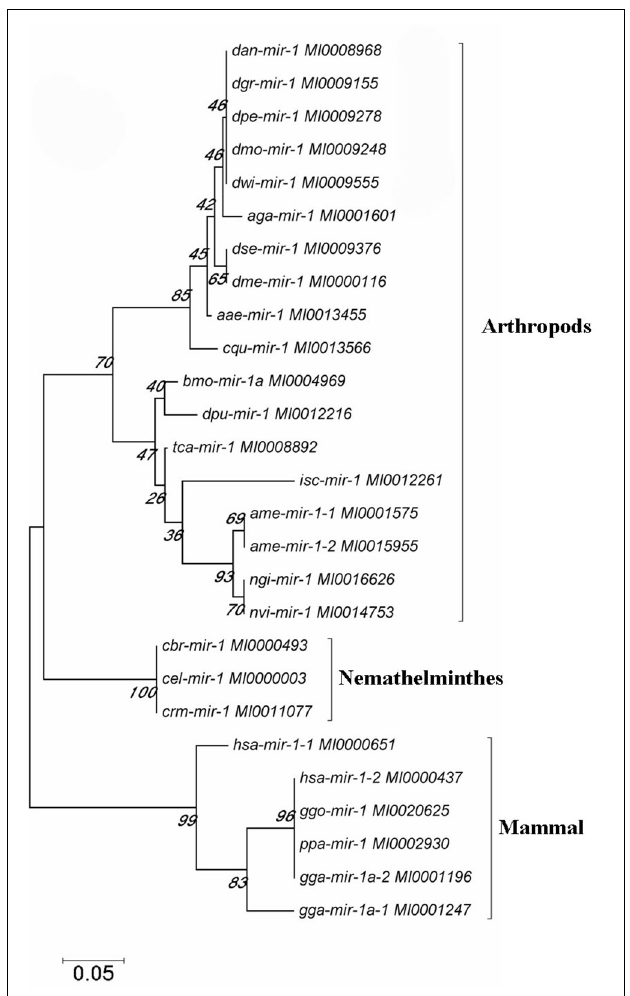
FIGURE 6 | The phylogenetic tree was constructed for the miR-1 gene in selected species by neighbor-joining (MEGA 4.0 software) with maximum parsimony and 500 bootstrap replicates. Reference nucleotide sequences were selected by BLAST searches of the NCBI nt database.